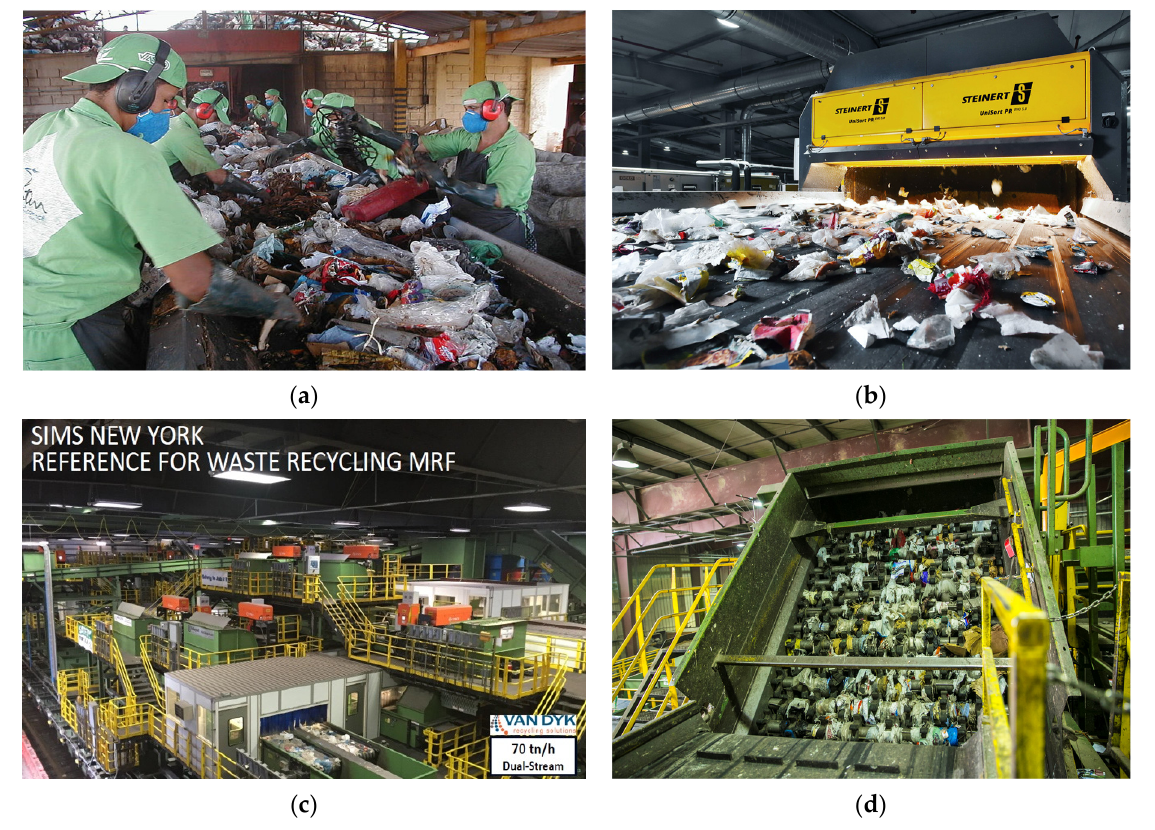
Figure 3. ( a ) Manual sorting process at MRFs, ( b ) automated sorting using optical sorter, ( c ) over- view of an MRF sorting facility using multiple automated sorters, and ( d ) tanglers as a key problem encountered by MRFs. Extracted from cleantechloops, steinertglobal, simsmunicipal,